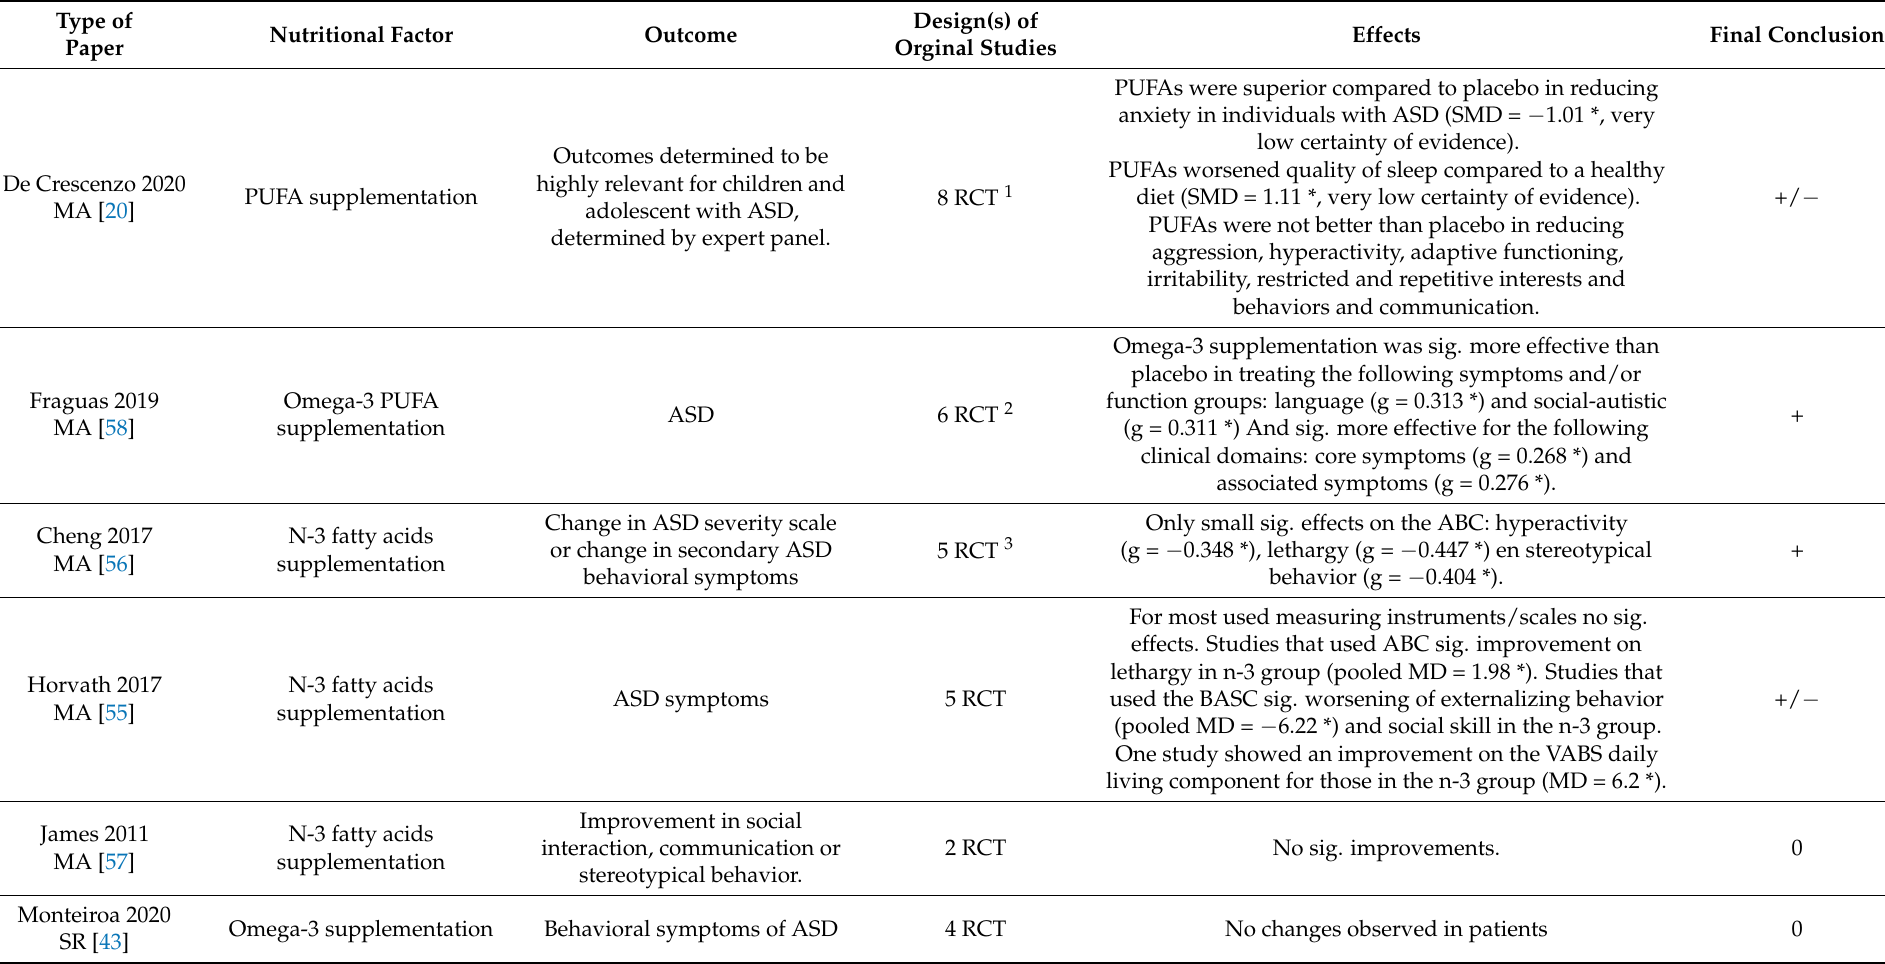
Table 4. Meta-analyses and systematic reviews concerning the effect of N-3, N-6 or PUFA supplementation on